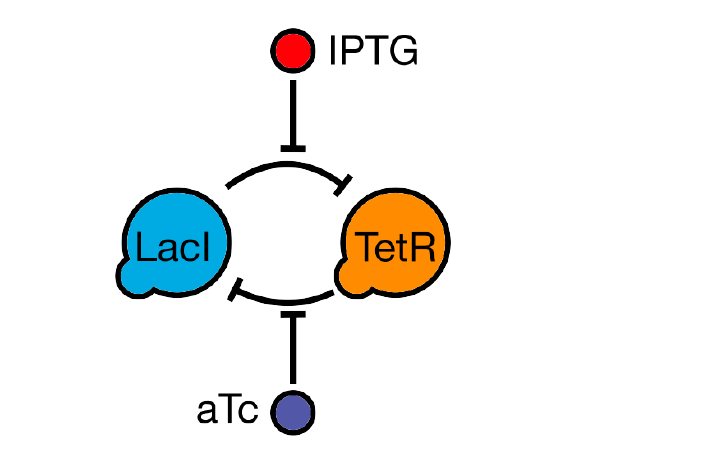
Figure 27: Conceptual diagram of LacI/TetR toggle switch: the LacI and TetR transcription factors are arranged to mutually repress each other’s expression, creating a bi-stable system. Transition between the two states is triggered by the small-molecule signals aTc (which disrupts TetR repression) and IPTG (which disrupts LacI repression). 2.2.0 The LacI/TetR toggle switch is modeled in SBOL as two parallel hierarchies of structure and function. The